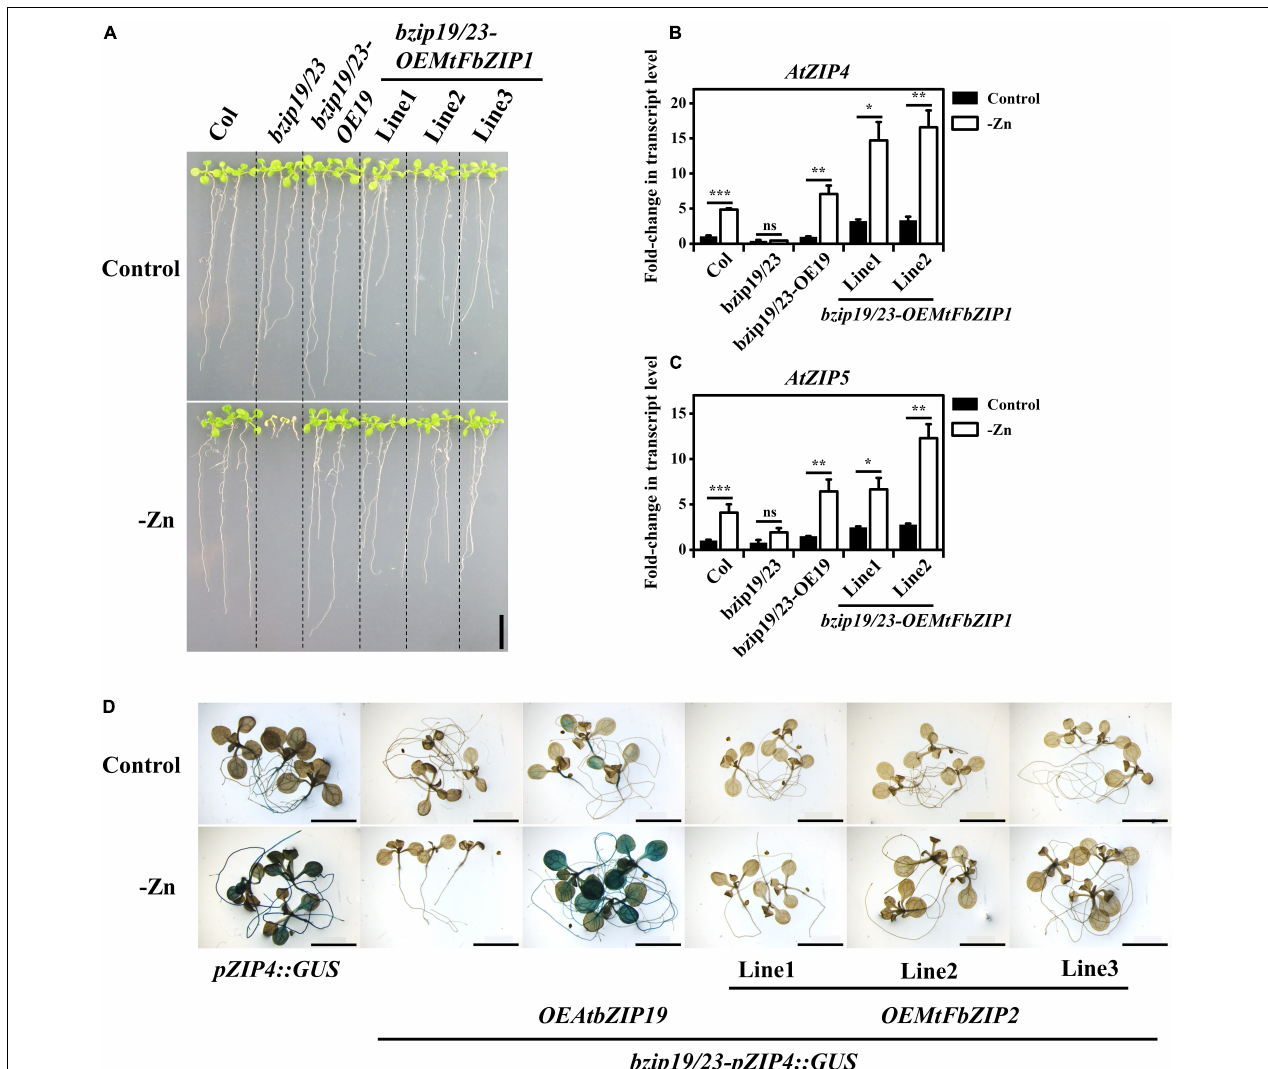
FIGURE 3 | Functional analysis of MtFbZIPs in Arabidopsis bzip19/23 double mutant. (A–C) Complementation analysis with bzip19/23-OEMtFbZIP1 lines, wild-type (Col), bzip19/23 double mutant and bzip19/23 - OEAtbZIP19 ( bzip19/23 - OE19 ; Lilay et al., 2019) grown at Zn sufficiency (Control) or Zn deficiency (–Zn). Homozygous T3 progeny of three independently transformed lines of bzip19/23-OEMtFbZIP1 are designated Line 1–3. (A) Phenotype of 2-week-old seedlings grown on MS medium. Scale bar = 1 cm. (B,C) Gene expression analysis of (B) Arabidopsis ZIP4 ( AtZIP4 ) and (C) Arabidopsis ZIP5 ( AtZIP5 ) in 2-week-old seedlings. Data represent mean-fold change in transcript level ± SE ( n = 2–3 biological replicates). Significant differences between Control and –Zn treatments were determined by Student’s t -test (* p < 0.05, ** p < 0.01, *** p < 0.001, ns means not significant). (D) Histochemical GUS staining analysis of pZIP4:GUS , bzip19/23-pZIP4:GUS , bzip19/23-pZIP4:GUS-OEAtbZIP19 (bzip19/23-pZIP4:GUS-bZIP19; Lilay et al., 2021 ) and bzip19/23-pZIP4:GUS-OEMtFbZIP2 lines. The images represent 10–15 12-day-old seedlings grown with Zn sufficient (Control) or Zn deficient (–Zn) MS medium. The bzip19/23-pZIP4:GUS-OEMtFbZIP2 lines are T2 progeny of three independently transformed lines designated Line 1–3. Scale bars = 5